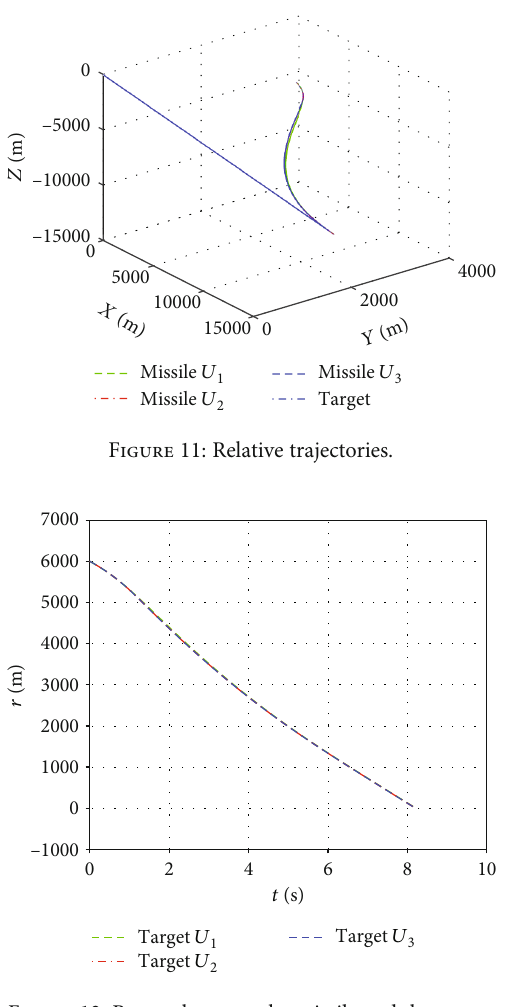
Figure 9: Acceleration instruction u